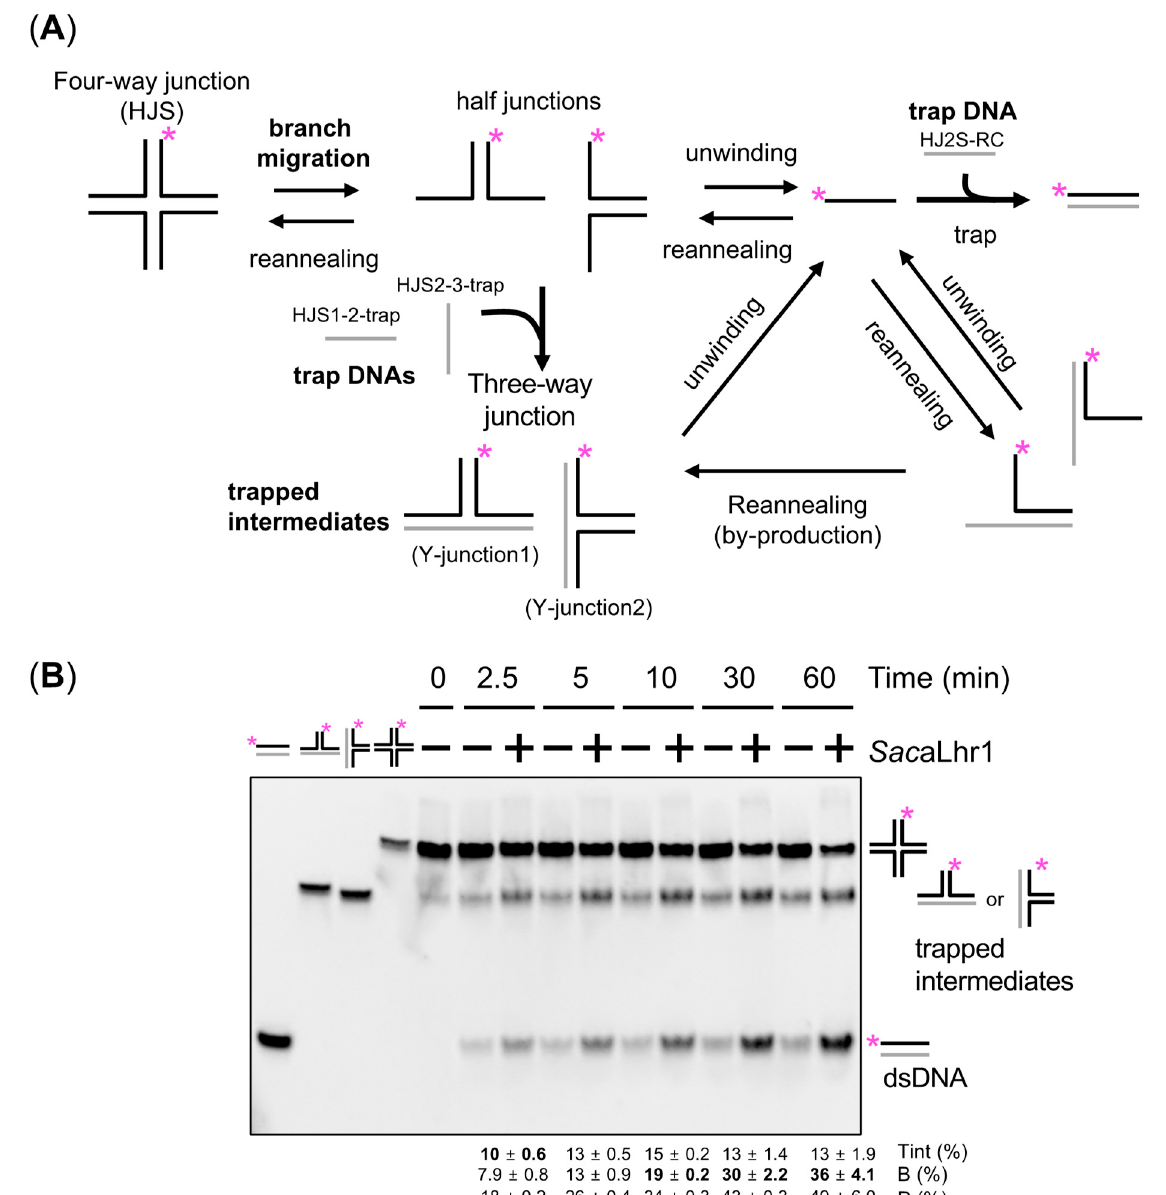
Figure 7. Branch migration activity of Sac aLhr1 for synthetic HJ. ( A ) Schematic drawing of the pos- sible unwinding and reannealing processes of substrate DNA. Gray lines and asterisks indicate the trap DNA molecules and 5 ′ -DyLight 5 labels, respectively. ( B ) Synthetic HJ (10 nM) were incubated with (+) or without ( − ) Sac aLhr1 (225 nM) at 70 °C for 0–60 min. Bands were assigned and indicated on the right side of the panel. Amounts of trapped intermediates (Tint%) (trapped intermediates per total DNA), dsDNA (B%) (dsDNA per total DNA), and product (P%) (trapped intermediates and dsDNA per total DNA) were quantified using band intensities obtained via scanning the gel image and indicated under the panel. For each band, intensity from the control reaction without protein was subtracted. Experiments were repeated thrice, and representative gel images are shown.